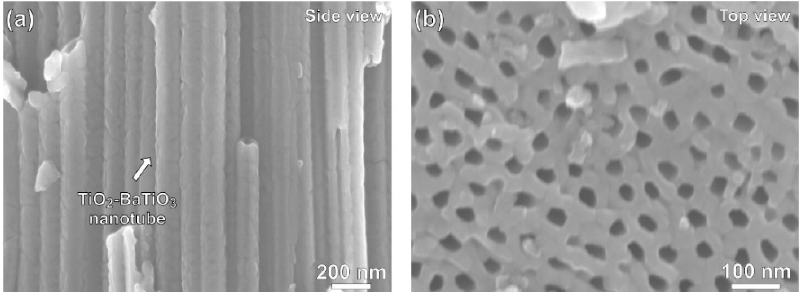
Figure 2. SEM images of a vertically aligned and uniformly shaped TiO 2 -BaTiO 3 nanotubes. ( a ) Side view and ( b ) top view of TiO 2 -BaTiO 3 nanotubes.